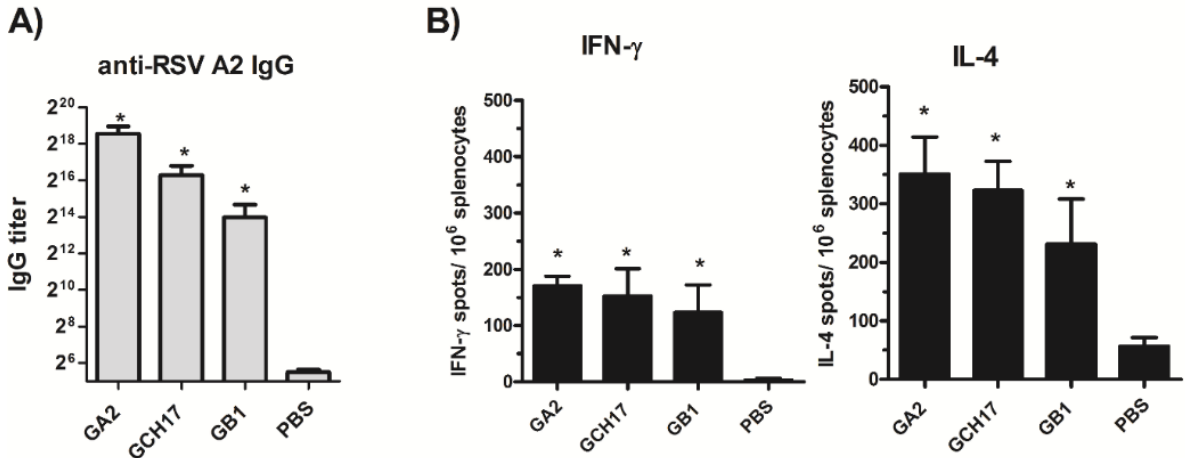
Figure 5. Humoral and cellular responses induced by LbL nanoparticle